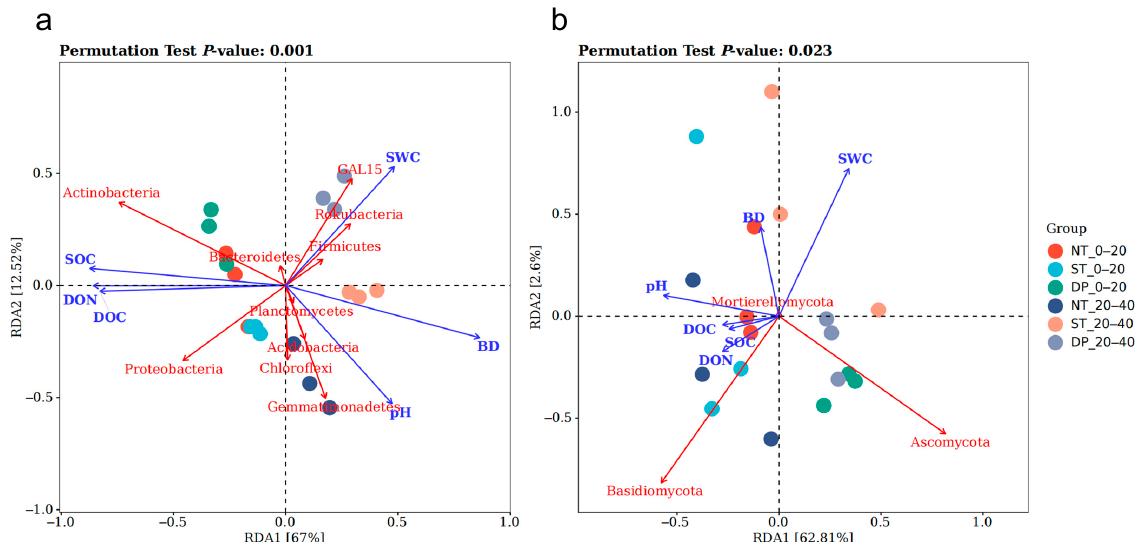
Figure 4. Redundancy analysis of soil physicochemical properties and communities of bacteria ( a ) and fungi ( b ) in the 0–40 cm soil layer under fallow tillage (select the top ten species of bacteria and the top three species of fungi). The blue arrows indicate the relative positions of the different environmental factors in the plane, with a longer arrow indicating a more significant effect. The red arrows indicate the relative positions of the major bacterial and fungal communities on the plane.